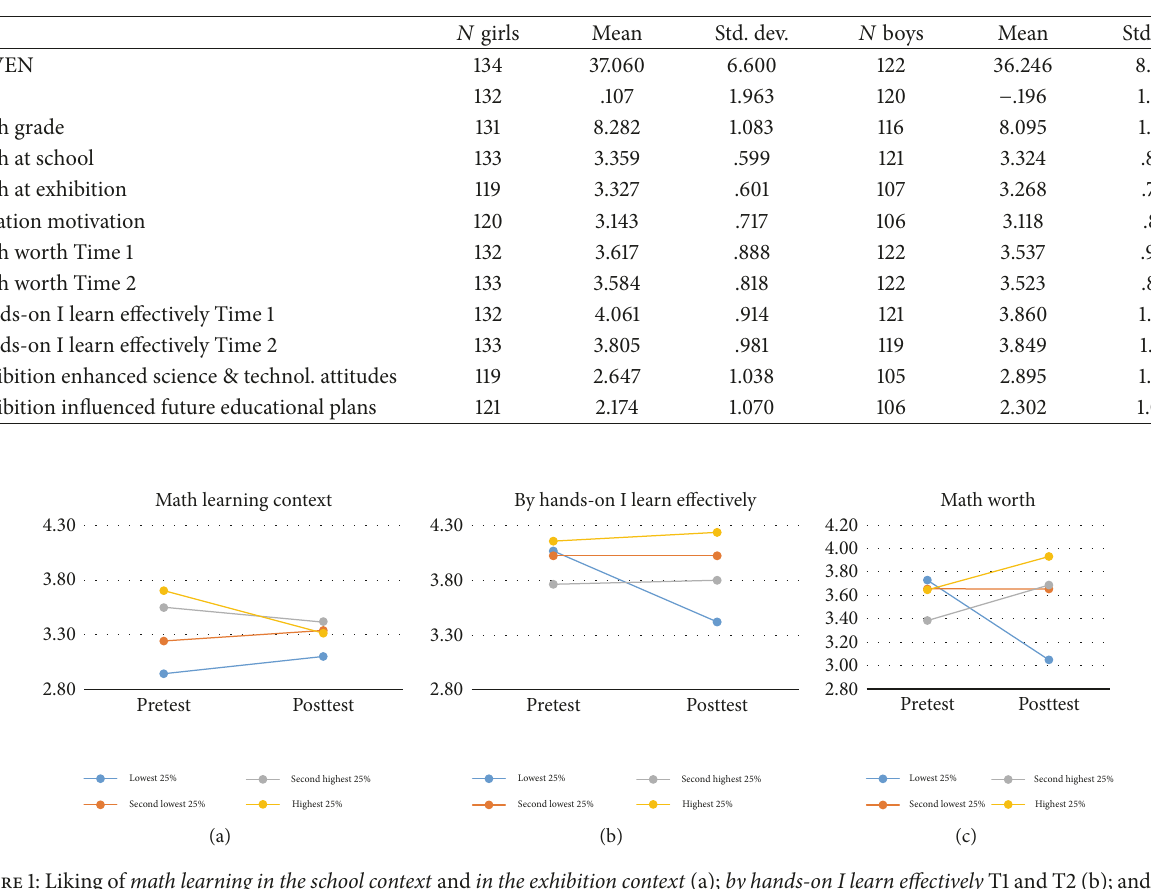
Table 1: Statistical descriptors by gender.